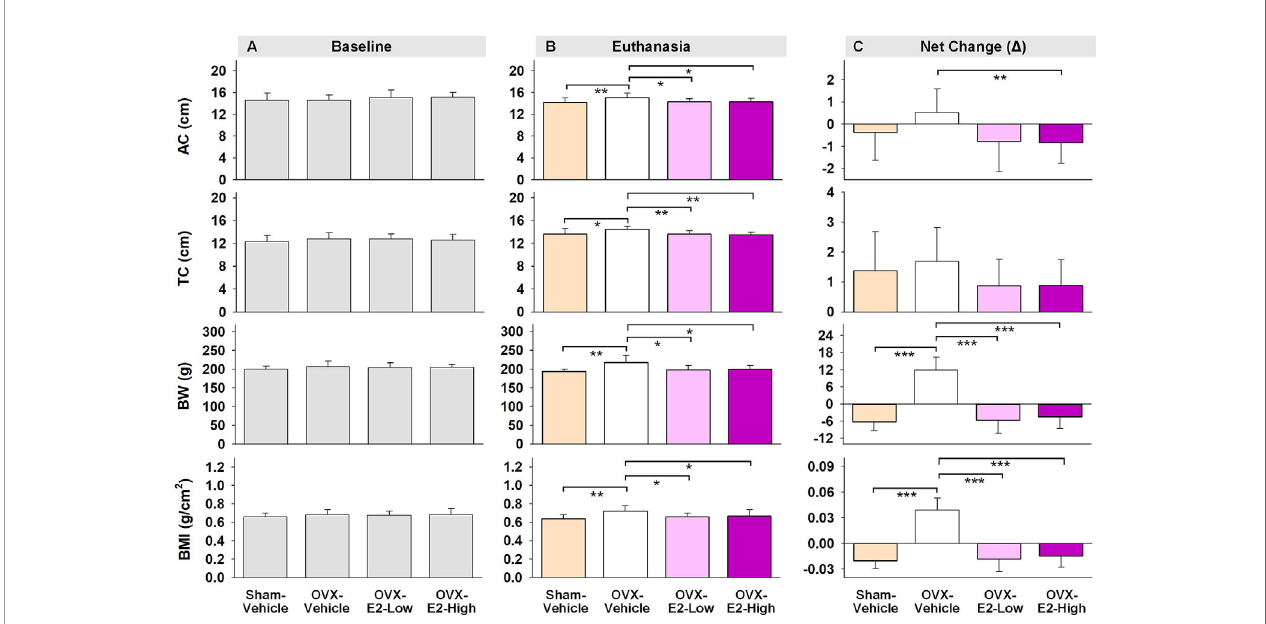
FIGURE 5 | Abdominal circumferences (AC), thoracic circumferences (TC), body weight (BW), and BMI at the beginning of experiment ( A , Baseline), at the end of experiment ( B , Euthanasia), and net changes (C) . The asterisks indicate signi fi cant differences (*p ≤ 0.05; **p ≤ 0.01; ***p ≤ 0.001; pairwise comparison using Fisher ’ s PLSD post hoc test after ANOVA). Group abbreviations (e.g., Sham-Vehicle) are described in Table 1 . Error bars indicate